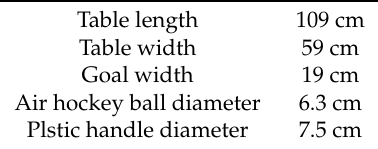
Figure 17. Air hockey table.